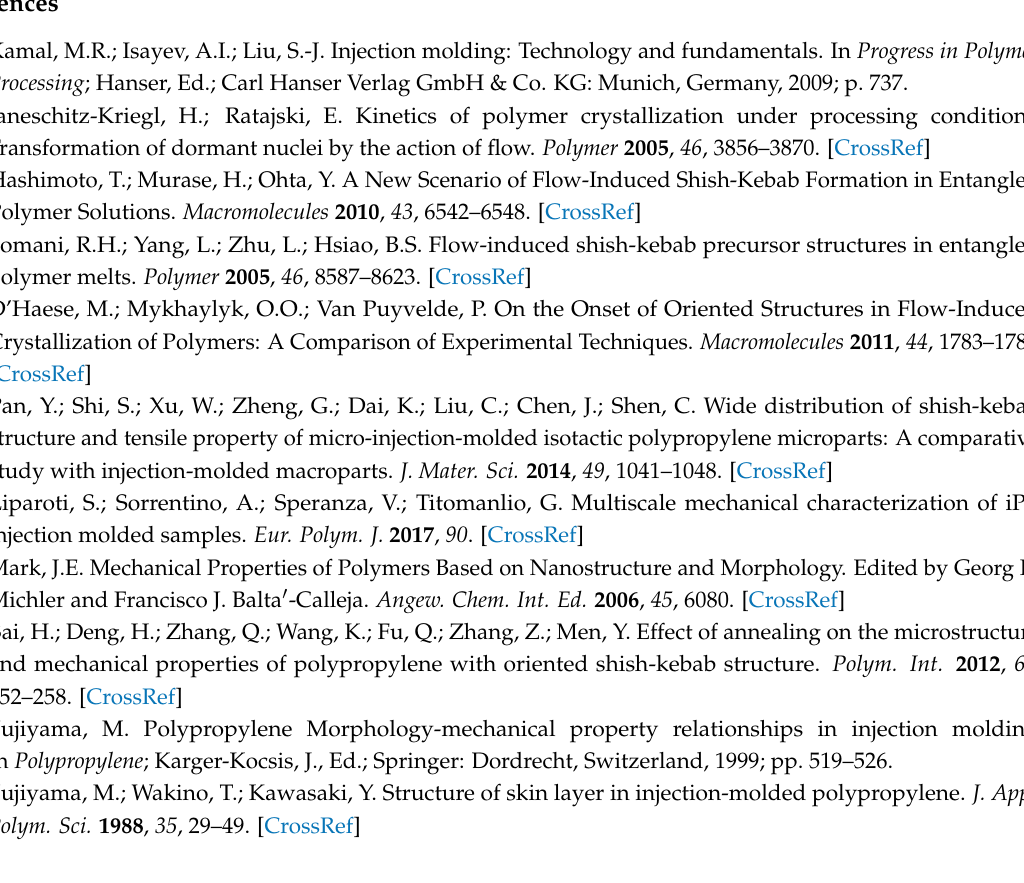
Figure S1: Temperature evolutions measured by means of a thermocouple type T located on the cavity surface at 20 mm from the cavity entrance during the tests 80-07, 80-1 and